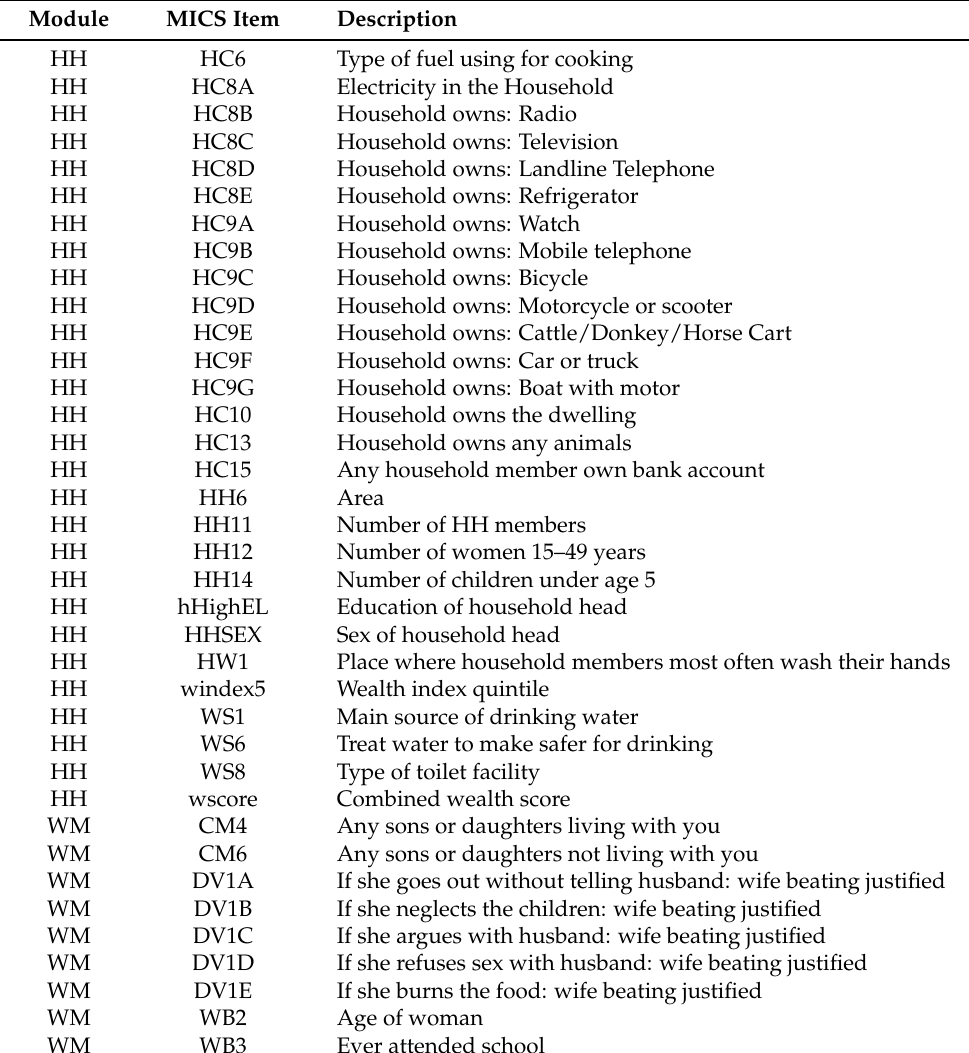
Table 1. Multiple Indicators Cluster Survey (MICS) items used in this study. HH: Household questionnaire, WM: Women’s